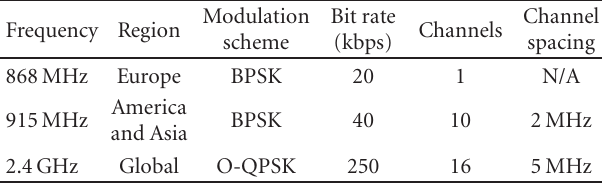
Table 1: Zigbee radio frequency